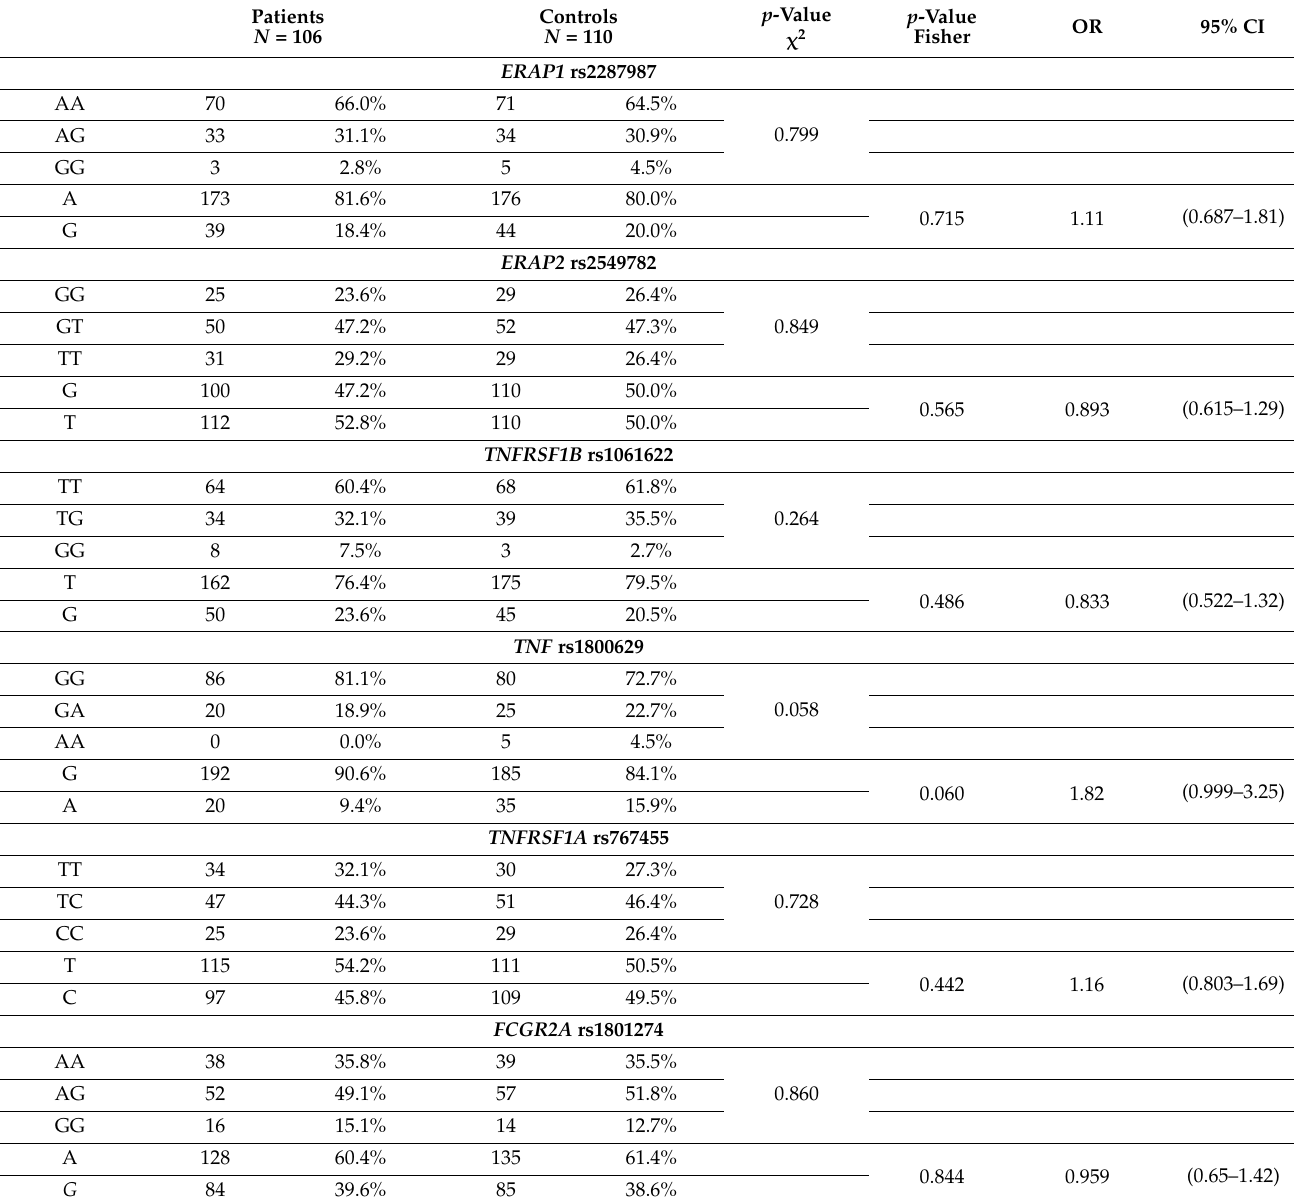
Table 3. The distribution of genotypes and alleles in AS patients and the control